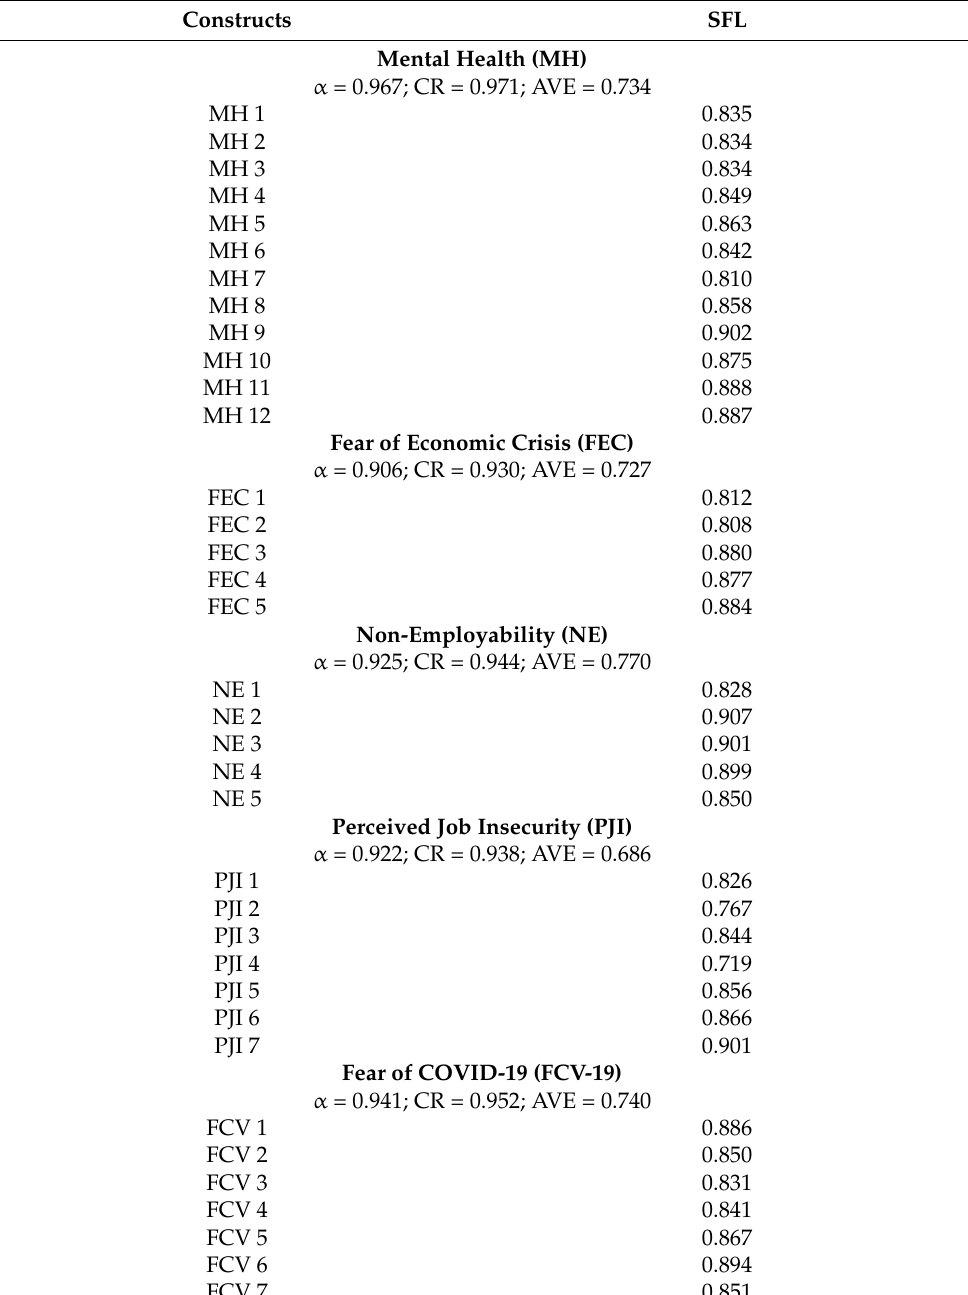
Table 2. Measurement items and standardized factor